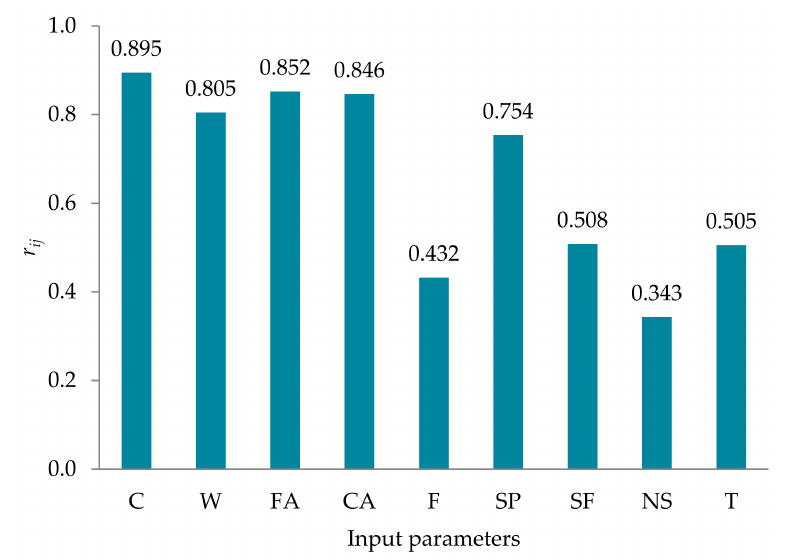
Figure 6. Sensitivity analysis